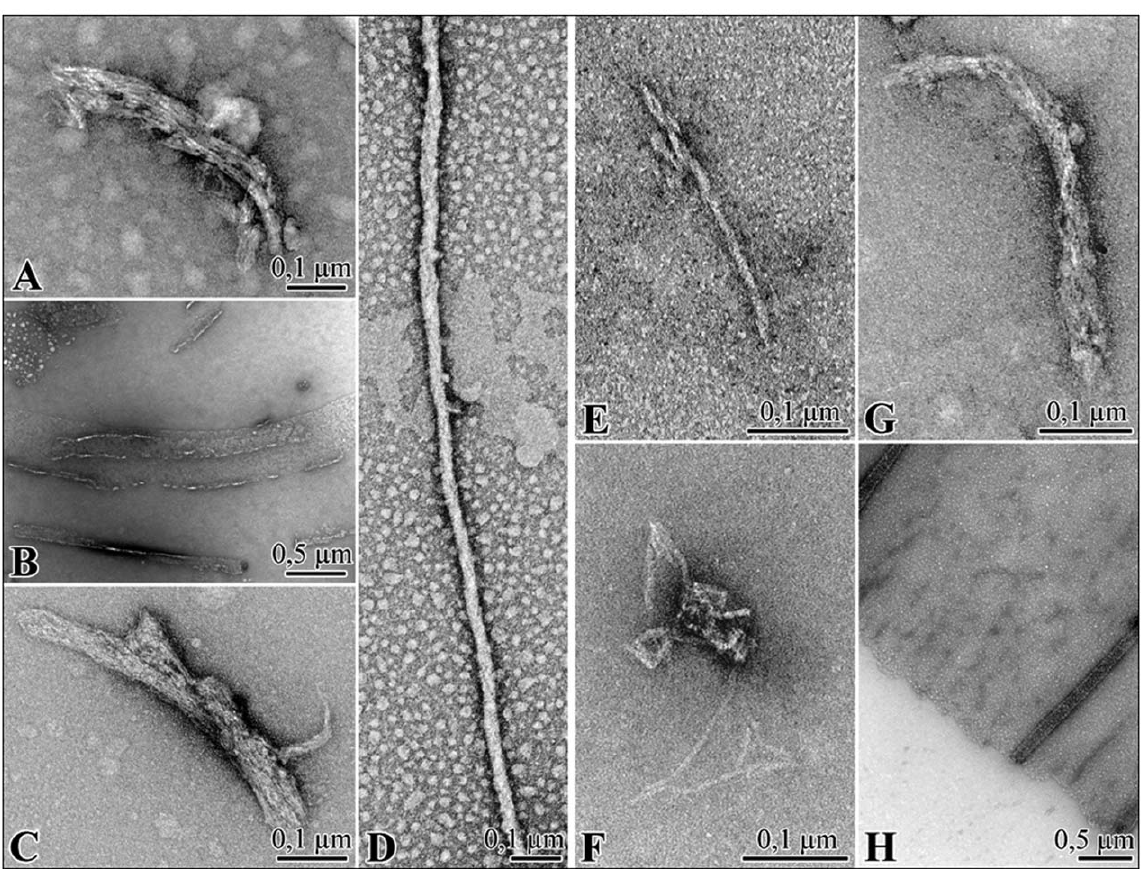
Figure 5. TEM images. Electron micrographs showing the ANP-CHF time course aggregation at pH 7.4 ( A,B,C,D ) and at pH 7.4 ( E,F,G,H ).